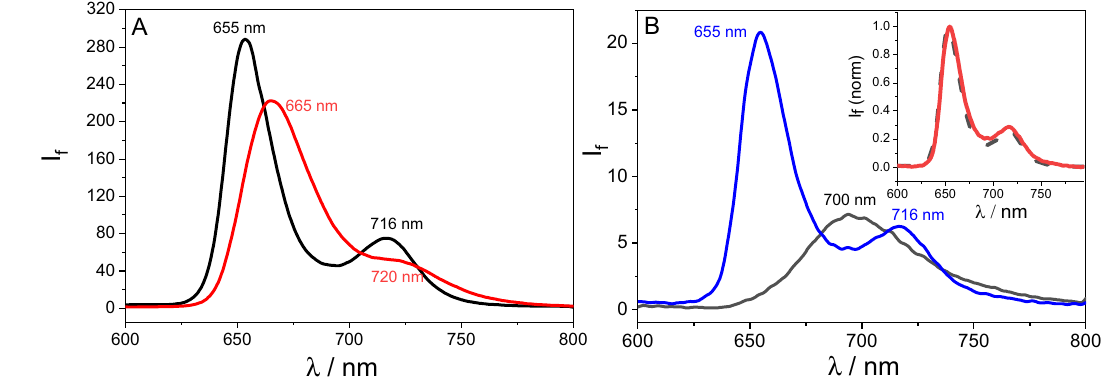
Figure 6. ( A ) Emission properties of TPPNH 2 (red) and GO-CONHTPP (black) in DMF, λ exc = 419 nm. ( B ) Fluorescence spectra registered for TPPNH 2 after the addition of 20 µL of 1 M HCl at two excitation wavelengths: 419 nm (blue) and 450 nm (black). Inset: Normalized fluorescence spectra of GO-CONHTPP in DMF and TPPNH 2 at excitation wavelength 419 nm in acidified DMF.